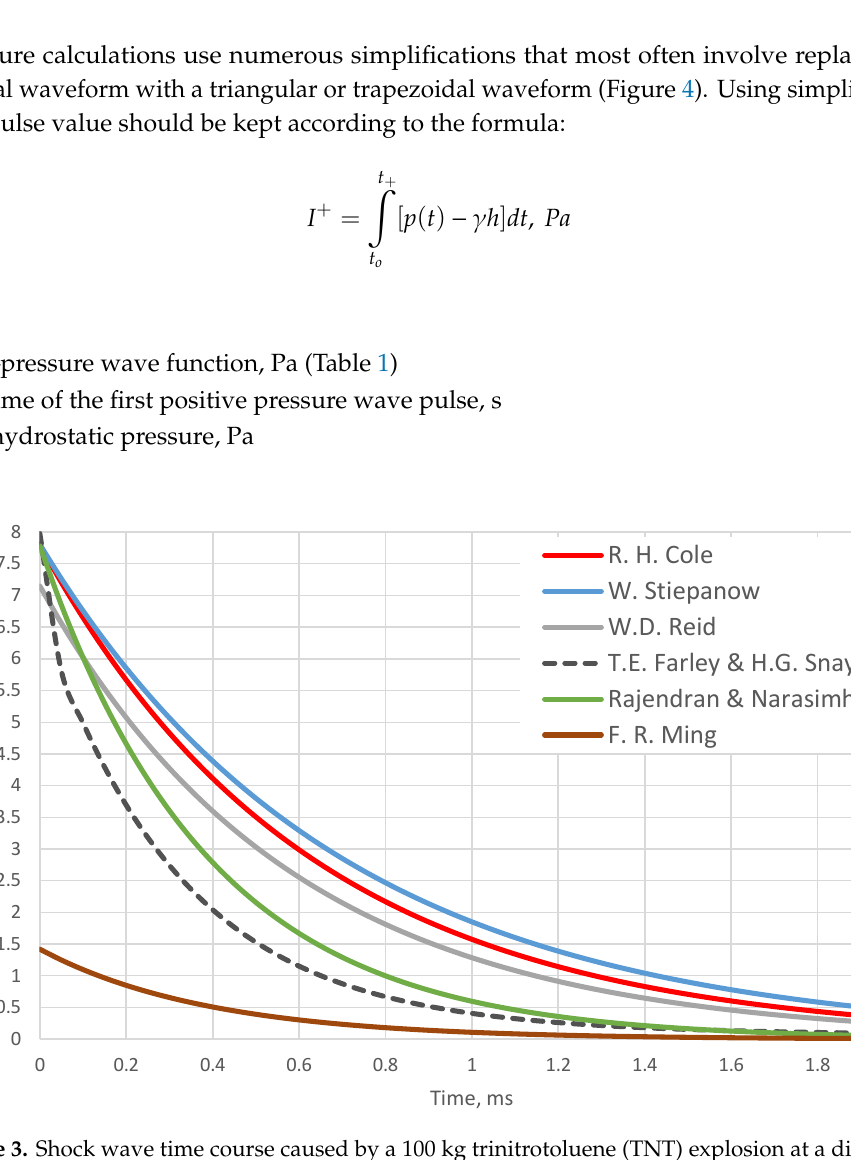
Figure 3. Shock wave time course caused by a 100 kg trinitrotoluene (TNT) explosion at a distance of 25 m described by various authors.